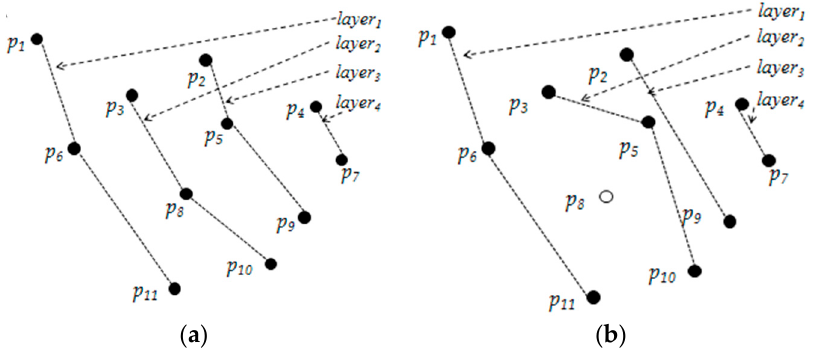
Figure 8. Updating skyline layers. ( a ) The original layers; ( b ) The new layers when p